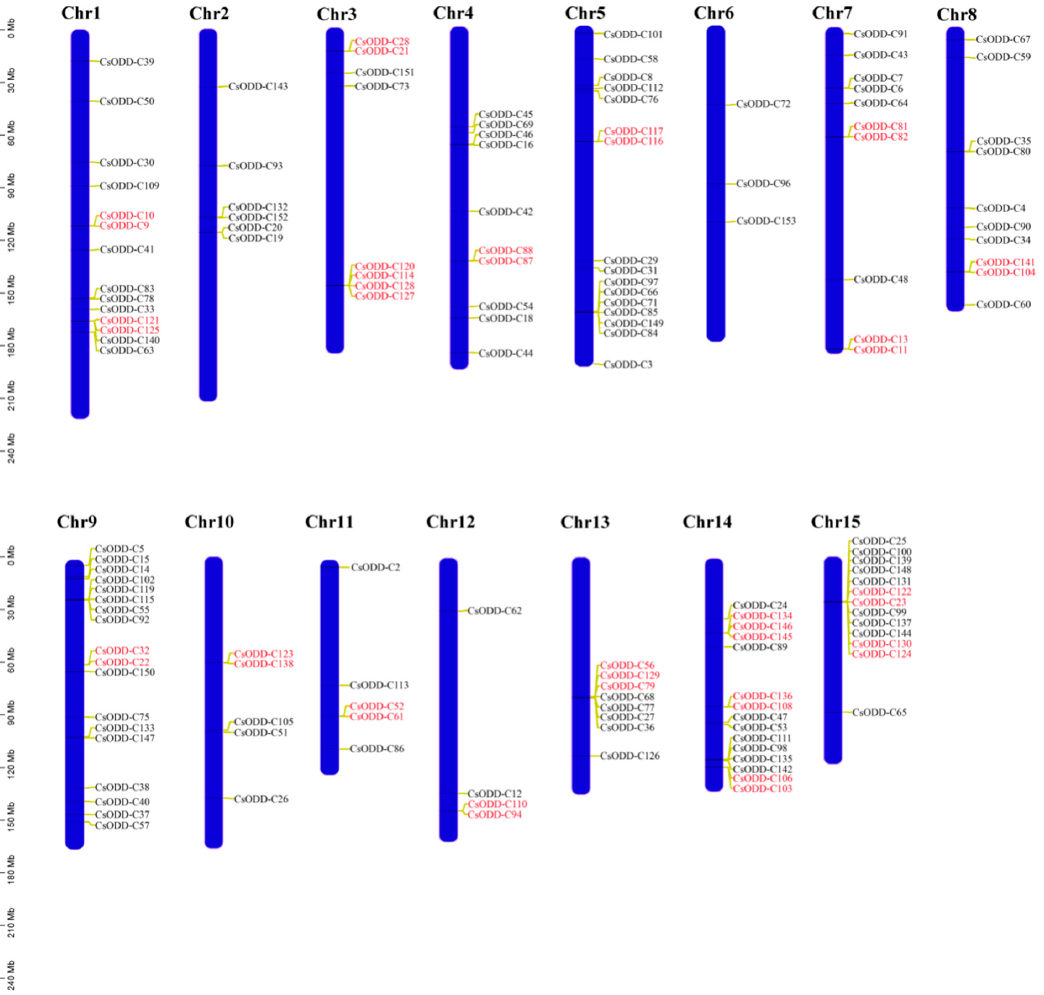
Figure 1. Chromosome distribution and tandem duplication events for Cs2ODD − C genes. The position of each Cs2ODD − C is noted on the right side of each chromosome (Chr). The size of a chromosome is indicated by its relative length. Tandemly duplicated genes are indicated with a red